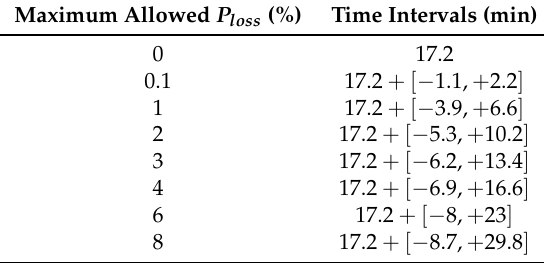
Table 2. Maximum production loss at time intervals, where time interval is defined as: Optimal time + [ time range with the corresponding P loss